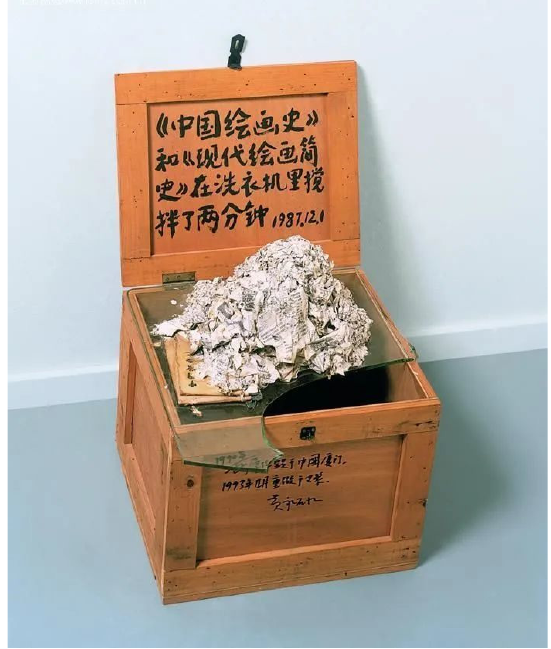
Figure 2 . “ The History of Chinese Painting and The Brief History of Western Modern Art Washed in the Washing Machine for Two Minutes” by Yongping Huang. Installation, 1990. This is a replica provided by the author in 1993. Picture from internet: https://new.qq.com/omn/20220125/20220125A03QS100.html (accessed on 27 October 2022).